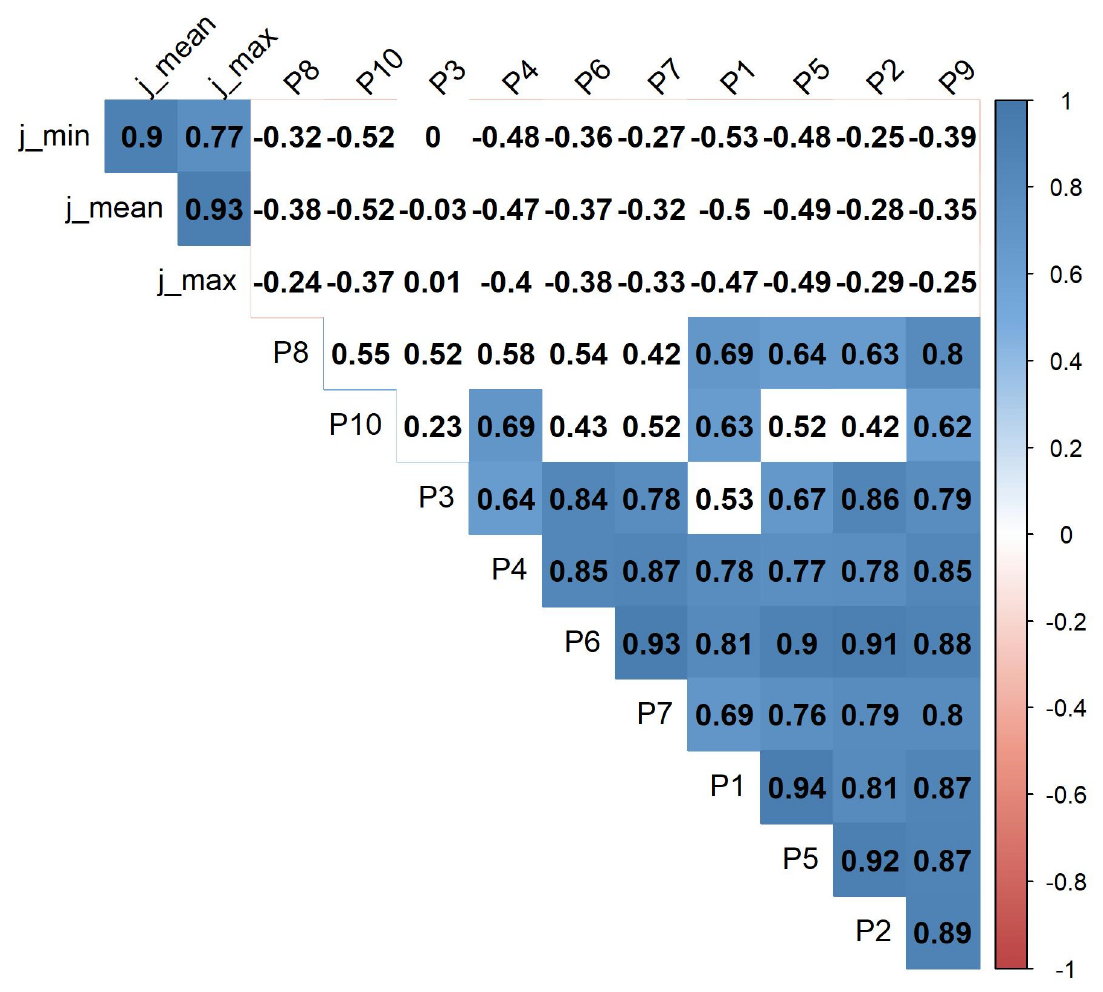
Figure 11. Correlations between water level and POW (Percentage of Open Waterbodies).